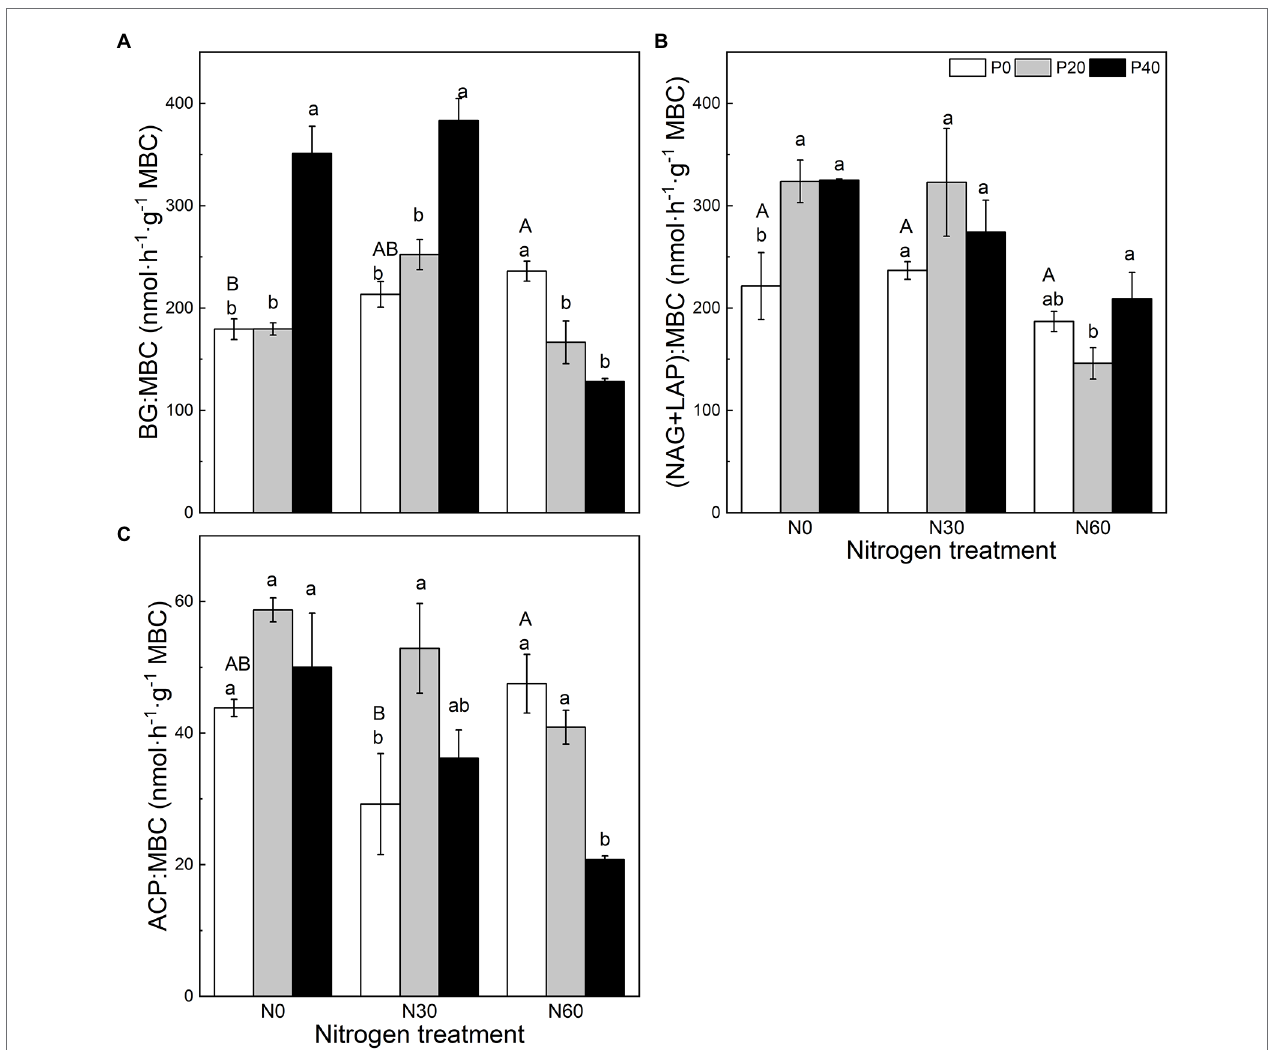
FIGURE 2 | The effect of simulated nitrogen (N) deposition and phosphorus (P) addition on the nutrient distribution of enzymes. (A) The ratio of BG activity to MBC. (B) The ratio of NAG and LAP activity to MBC. (C) The ratio of ACP activity to MBC. N0, 0 kg N ha − 2 year − 1 ; N30, 30 kg N ha − 2 year − 1 ; N60, 60 kg N ha − 2 year − 1 ;